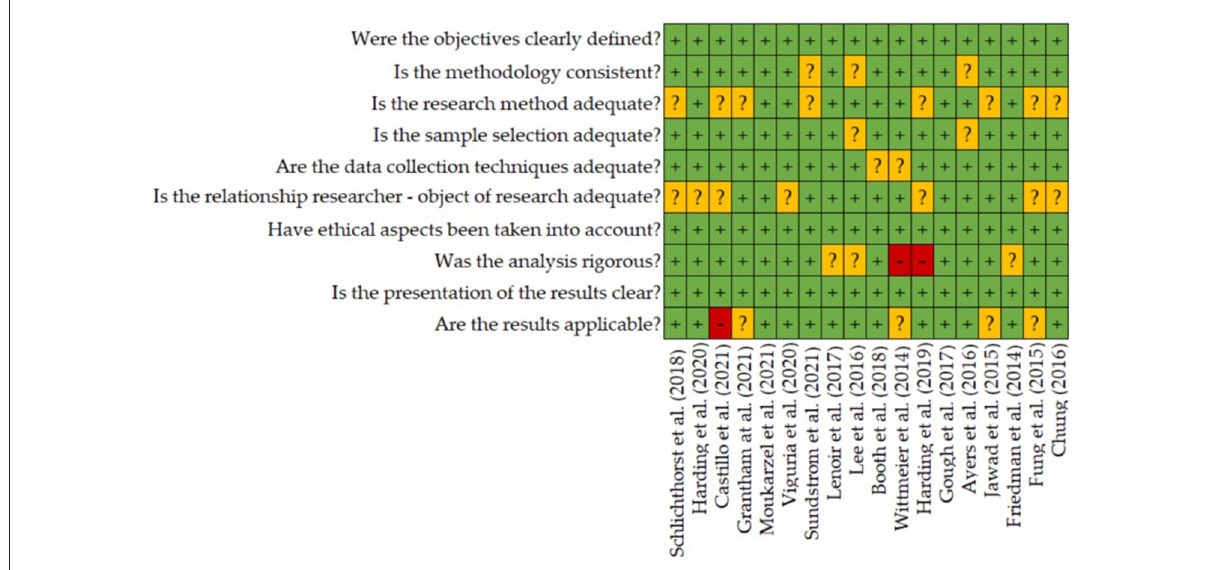
FIGURE4 Evaluation of the quality of the selected articles using the “Critical Appraisal Skills Programme”